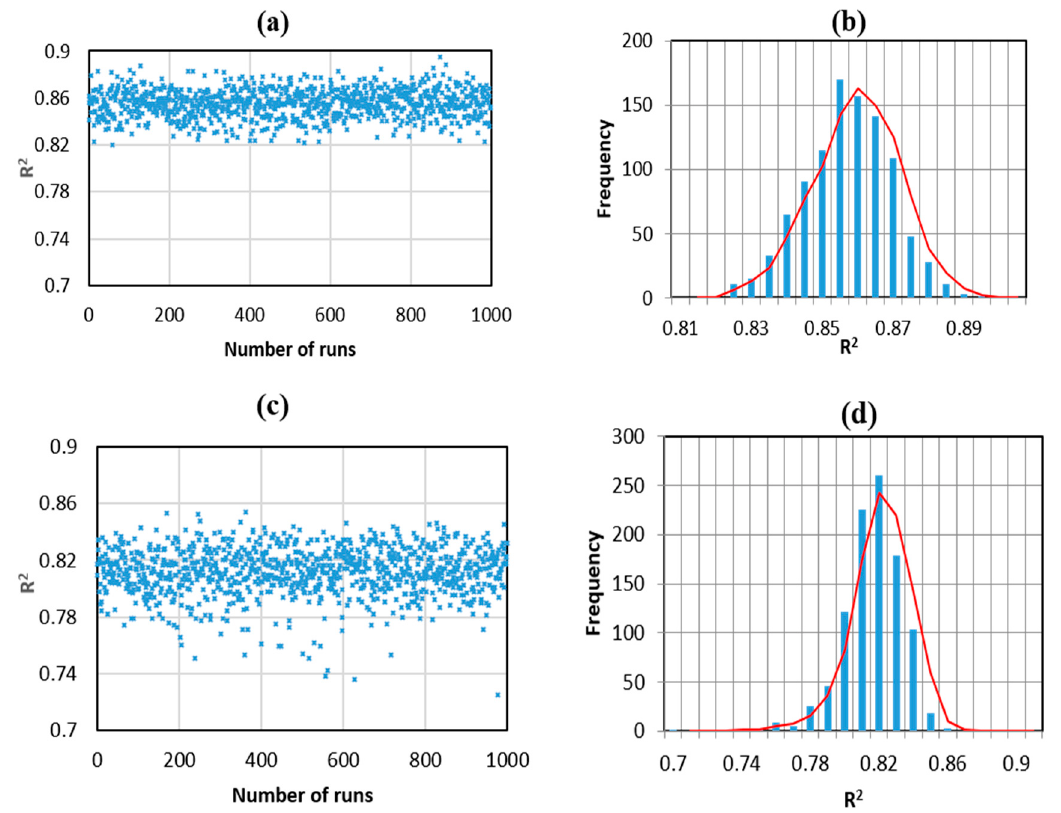
Table 6. Summary of the Monte Carlo simulations